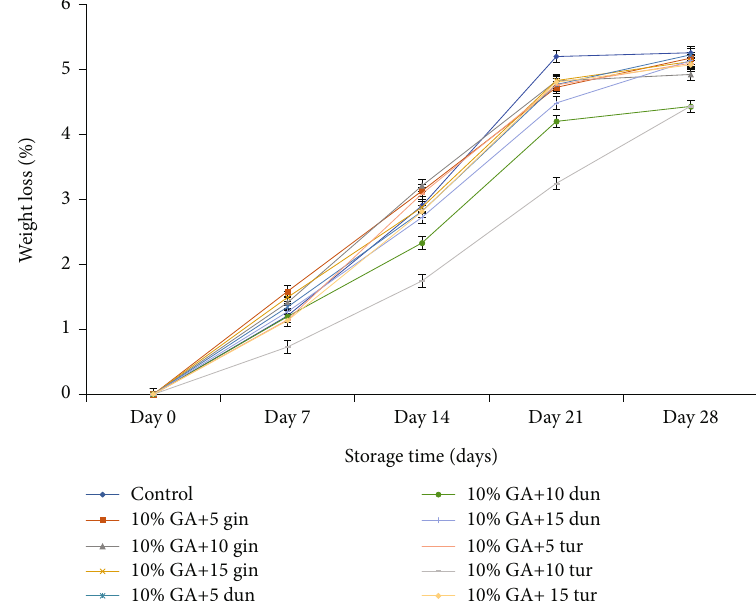
Figure 6: E ff ect of 10% GA incorporated with plant extracts at di ff erent concentrations on weight loss (%) during cold storage for 28 days.